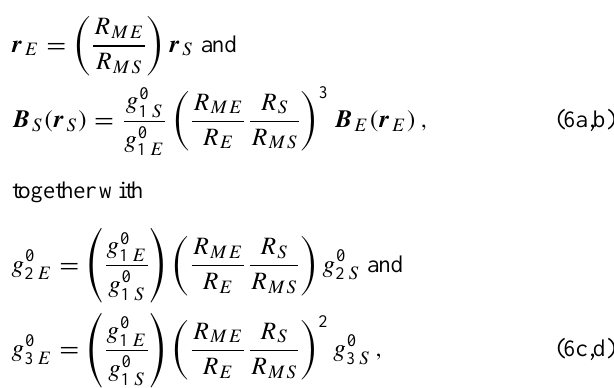
sen to represent the Voyager-1 data are (ω/(cid:127) S ) ∞ = 0 . 5, F o = 3200 nT R 2 (corresponding to 7.4 R S in the equatorial S plane, see Fig. 2a of the companion paper), and n = 4, while those for Voyager-2 are (ω/(cid:127) S ) ∞ = 0 . 55, F o = 2800 nT R 2 (corresponding to 9.7 R S in the equatorial plane), and n =